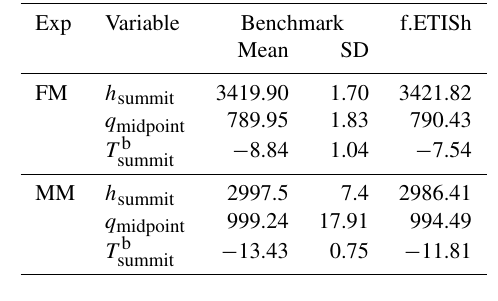
Table A1. Comparison of f.ETISh with the EISMINT-I fixed (FM) and moving margin (MM) experiment benchmark based on an en- semble of two to three models (Huybrechts et al., 1996) for the steady-state experiment.